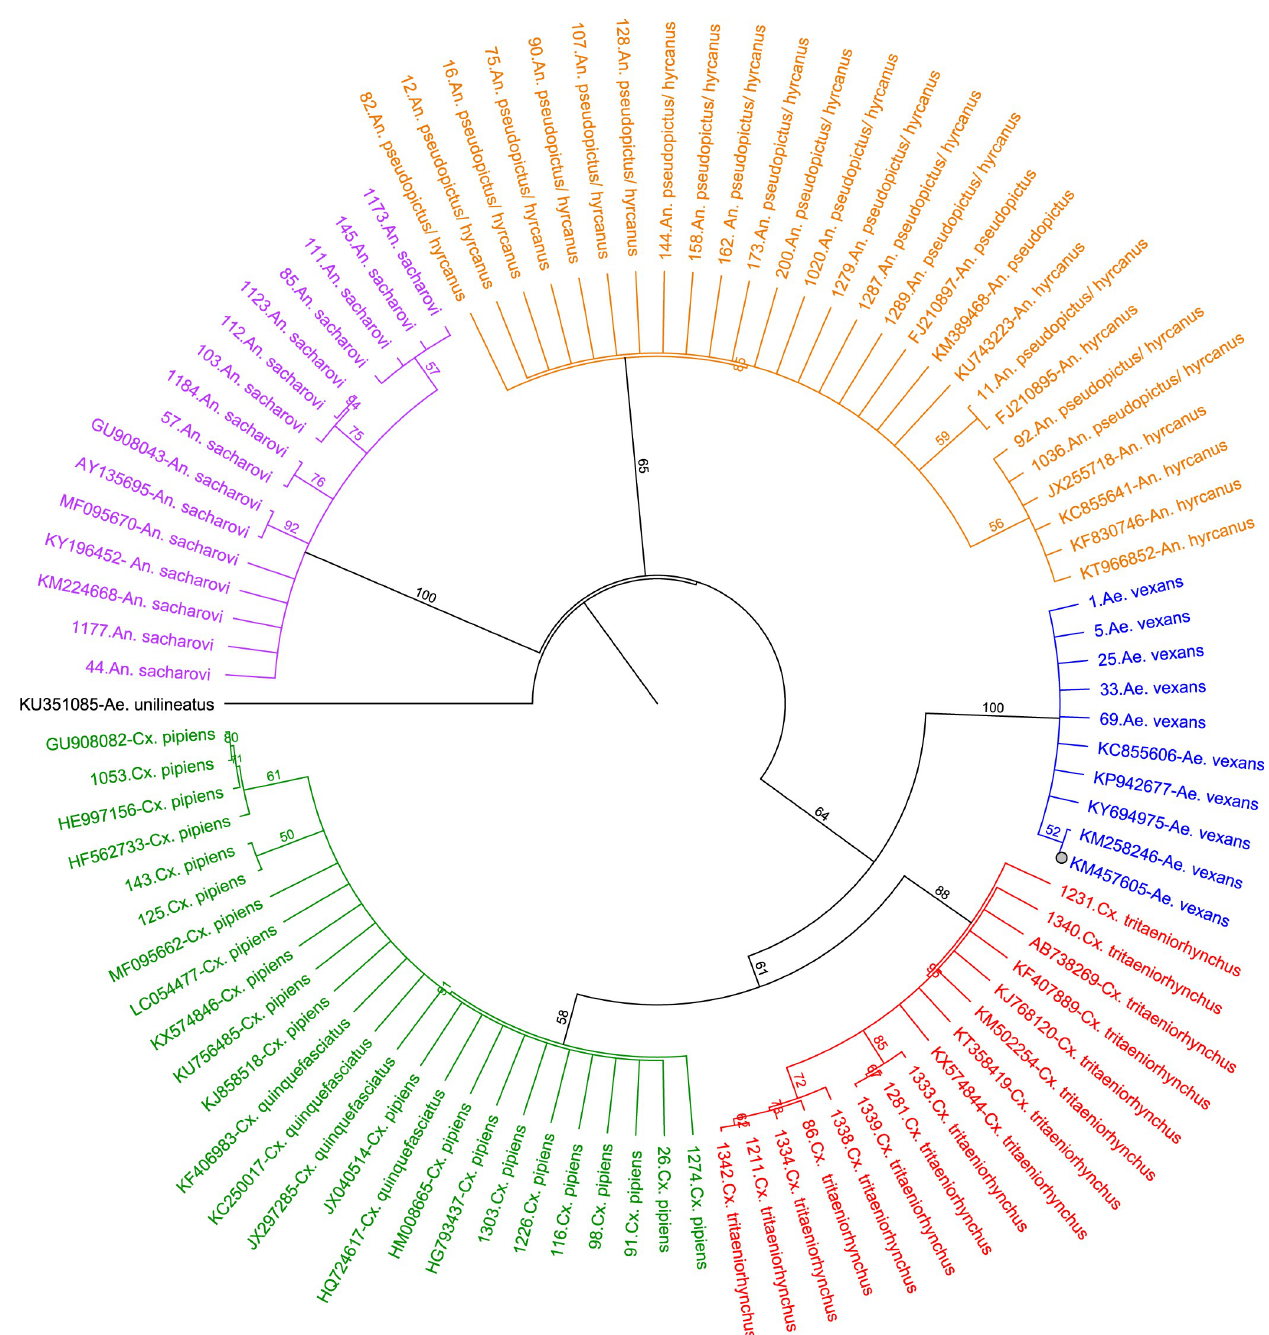
Fig 1. Phylogenetic tree based on COI sequences of 55 mosquitoes. An alignment of COI gene sequences (560 bp) was used to construct the NJ tree in Geneious 11.1.2 software. Numbers displayed on branches are the bootstrap support obtained through 1000 replications. Sequences obtained from GenBank are shown with accession